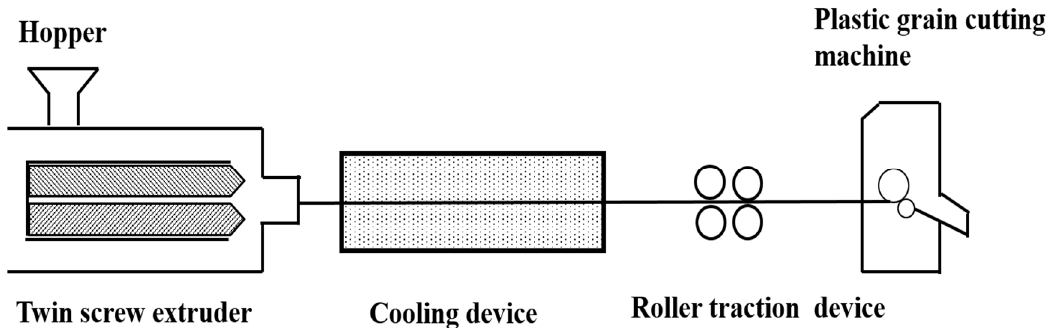
Figure 1. The melt-impregnation process of PLA/lignin biocomposites.